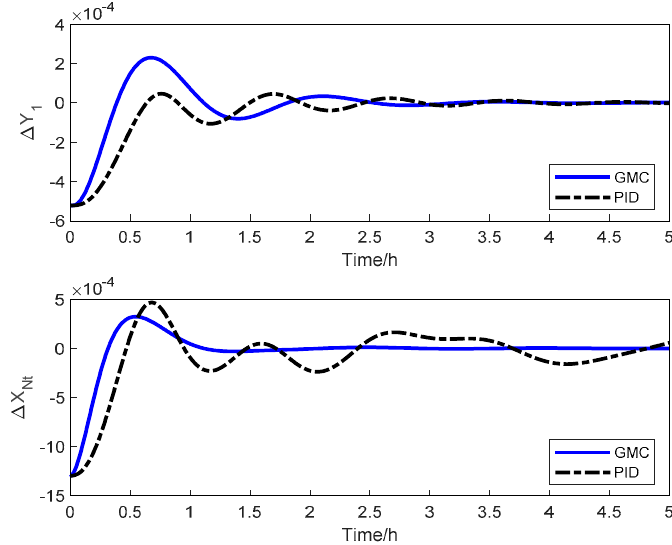
Figure 16. Servo response curve at the top and bottom of the tower.